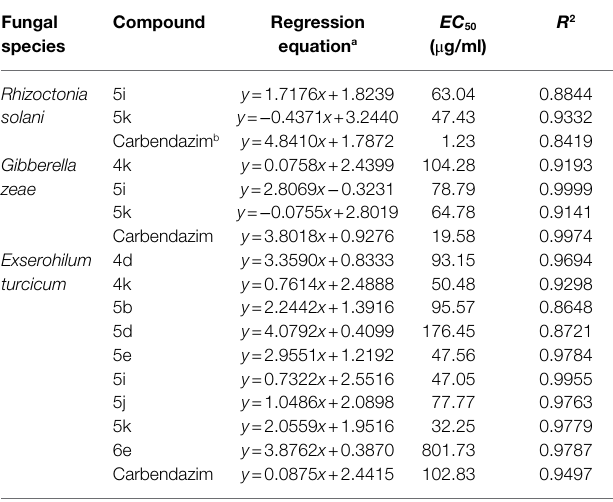
TABLE 2 | Antifungal activities with EC 50 of the target compounds against three plant pathogenic fungi in vitro . Fungal species